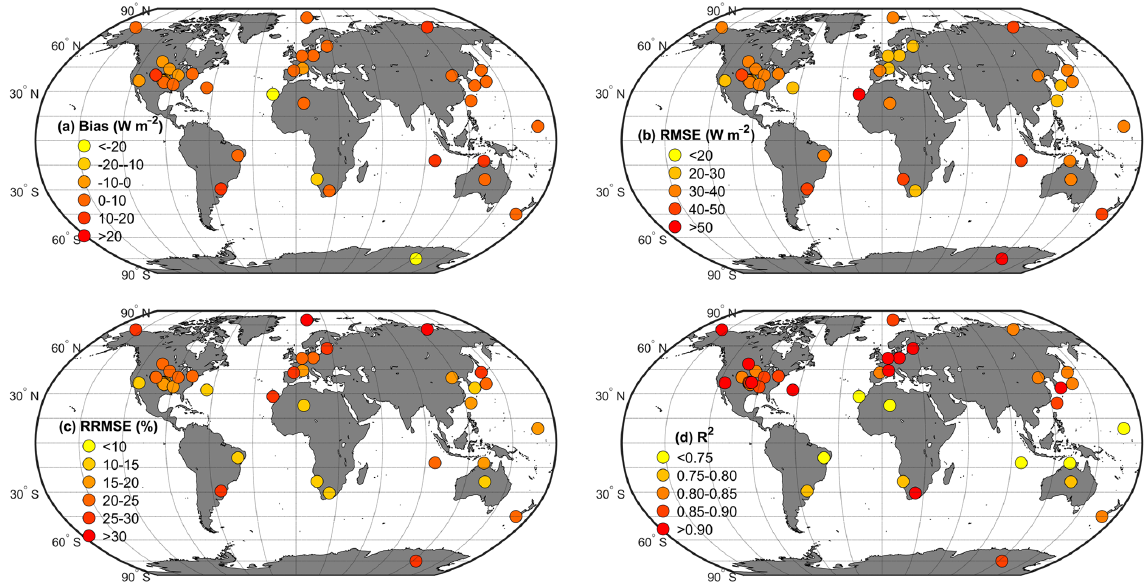
Figure 8. Spatial distributions of accuracy statistical metrics for EPIC-based daily total SW at all ground-based sites. Circles with different colors indicate their different